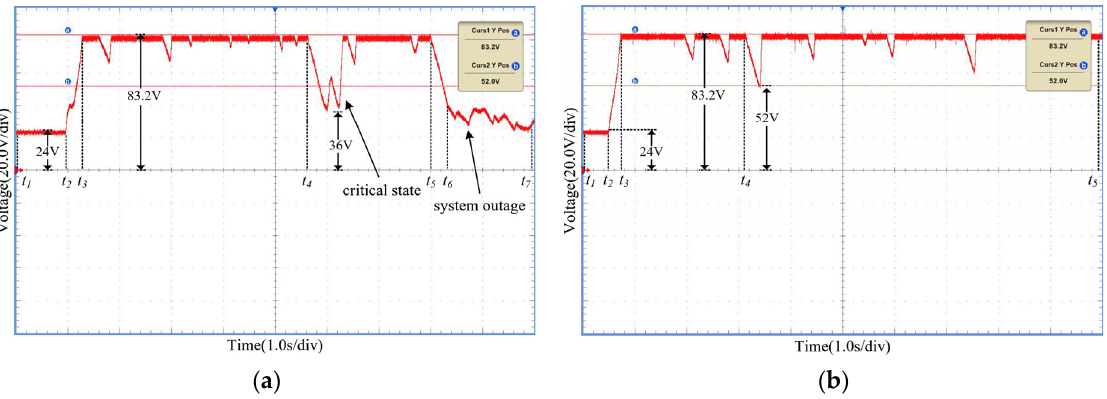
Figure 11. ( a ) The bus voltage of the system before this method is applied. ( b ) The bus voltage of the system after this method is applied.